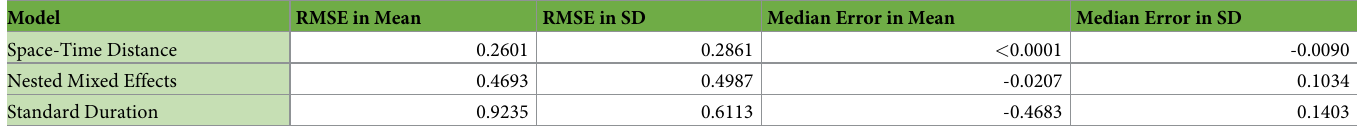
Table 3. Predictive validity of tested